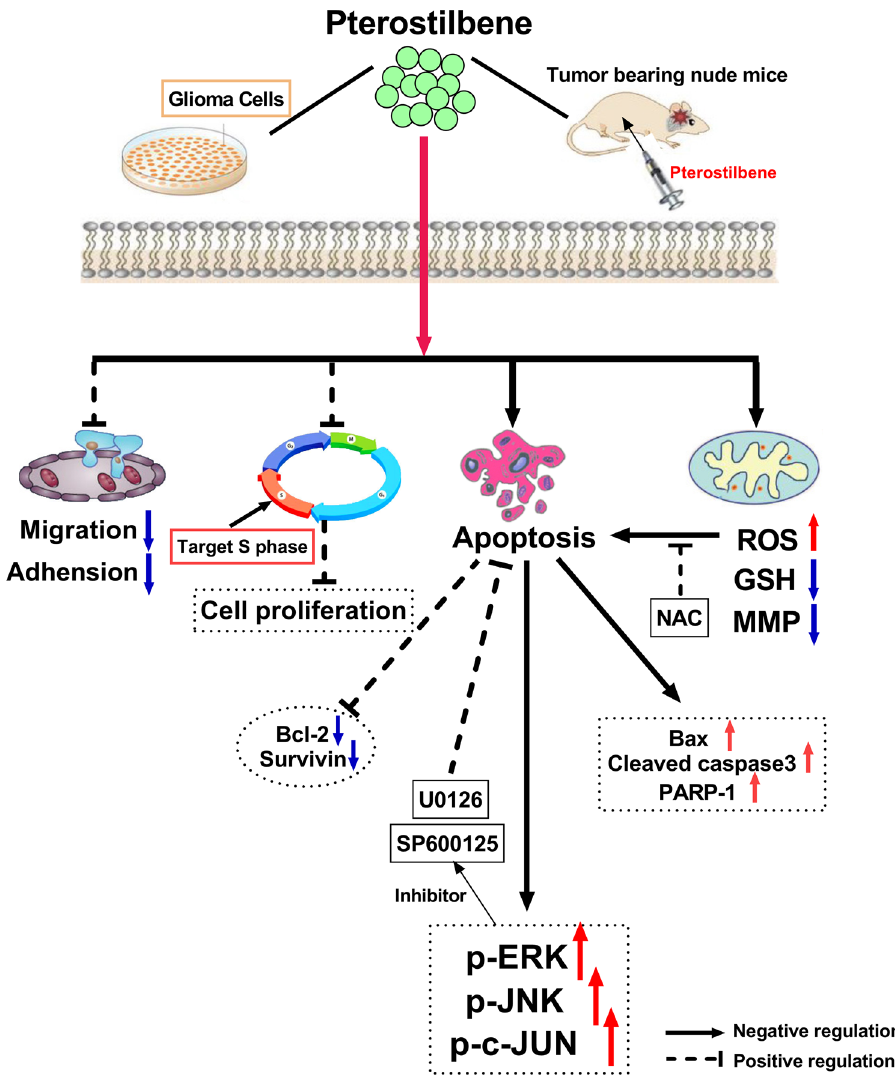
Figure 8. A possible network, describes the main mechanisms of PTE